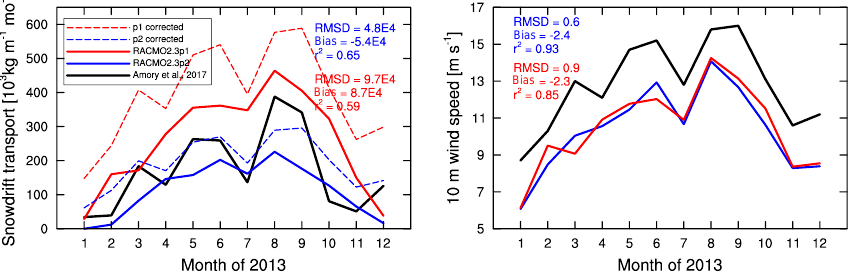
Figure 10. Monthly horizontal snow drift transport, TR ds (10 3 kgm − 1 month − 1 ) ( a ), and 10m wind speed, V 10m ( b ), from Amory et al. (2017), RACMO2.3p2 (blue) and RACMO2.3p1 (red) for the year 2013. The observed snow flux is calculated for the first 2m only. The dashed lines represent the modelled transport fluxes corrected for the bias in V 10m , using a first-order linear regression.